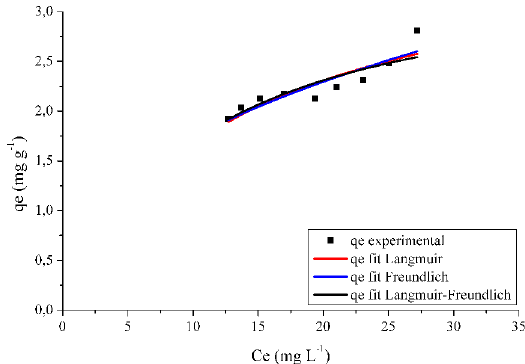
Figure 10. Experimental and predicted adsorption isotherms for tetracycline for the Langmuir, Freundlich and Langmuir-Freundlich models, at temperature of 45